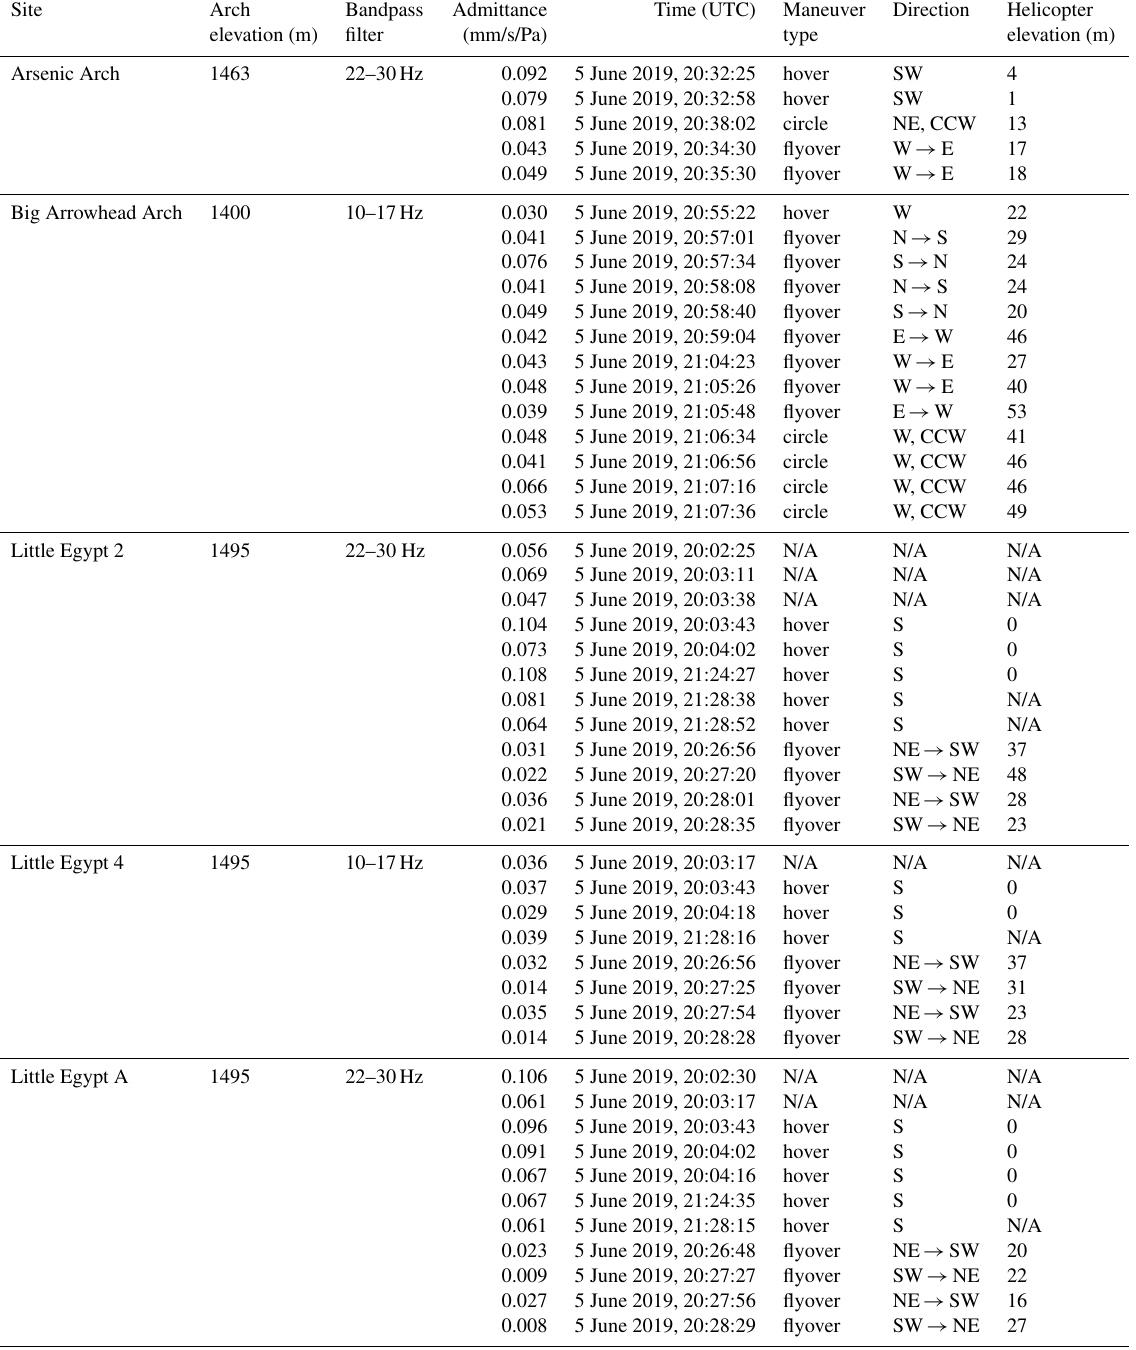
Table E1. Summary of admittance values for each study site. Arch elevation and bandpass filter range provided, along with admittance averaged for each maneuver. Times for each maneuver are also listed with the direction and elevation of the helicopter relative to the landform. CCW: